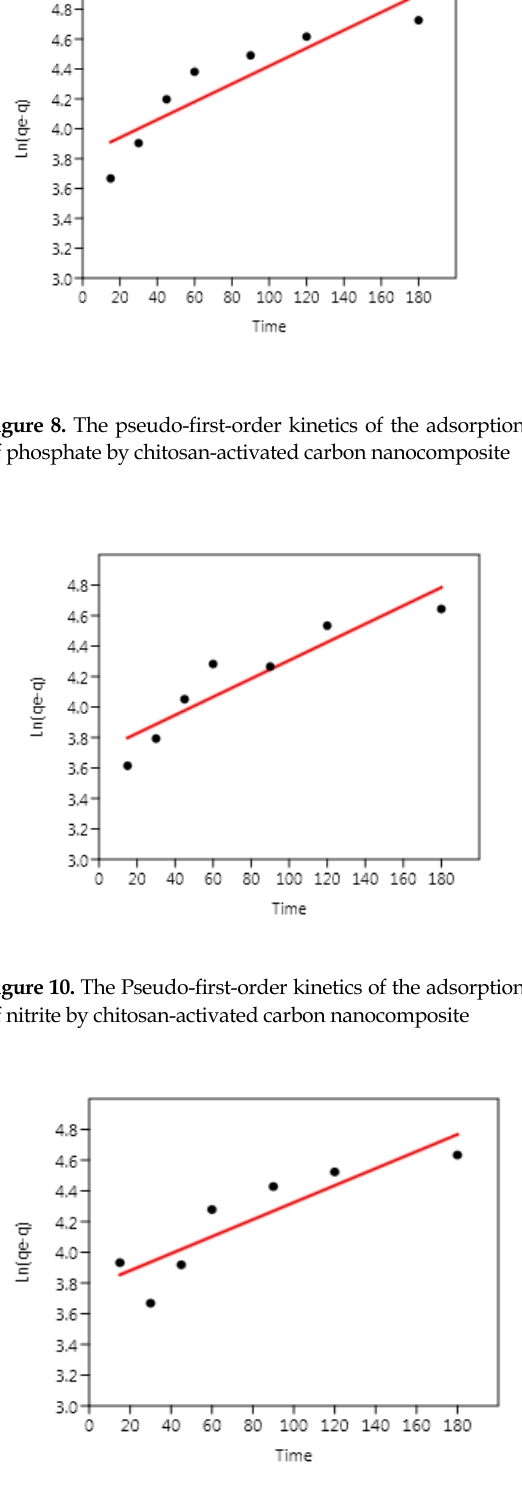
Rezaei H, et al. Isothermal and Kinetic Evaluation of Adsorption Fish Farm Effluents. J Adv Environ Health Res. 2021;